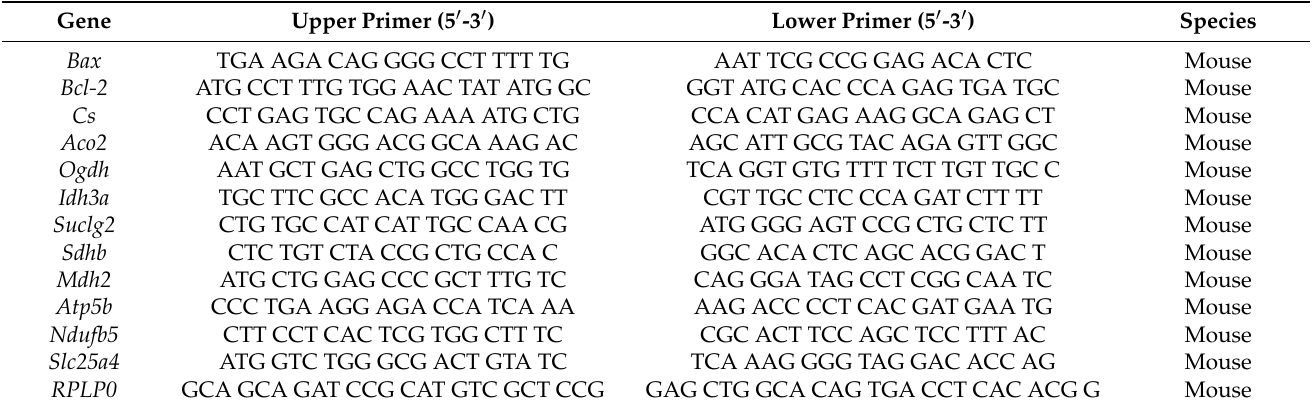
Table 2. Primers used for real-time